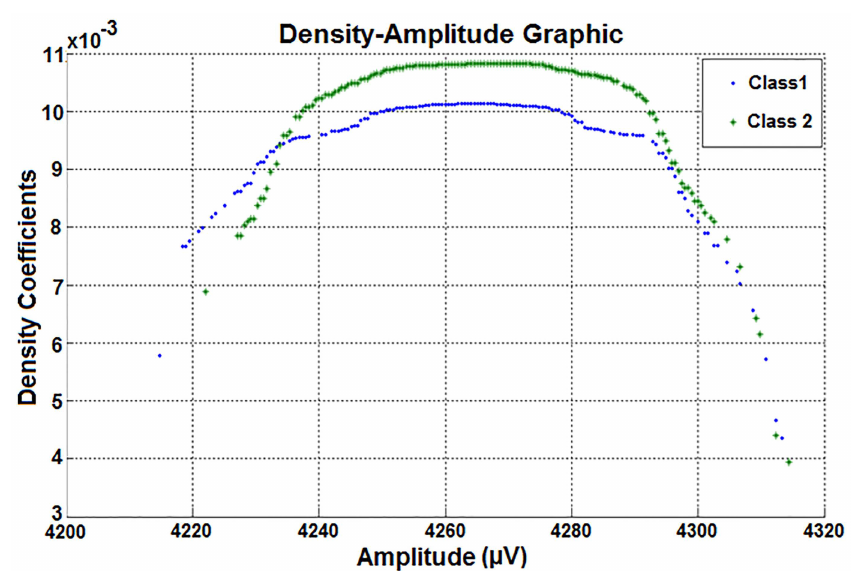
Fig 9. The density-amplitude representations of classes belonging to the same attribute. This attribute is also used in Figs 7 and